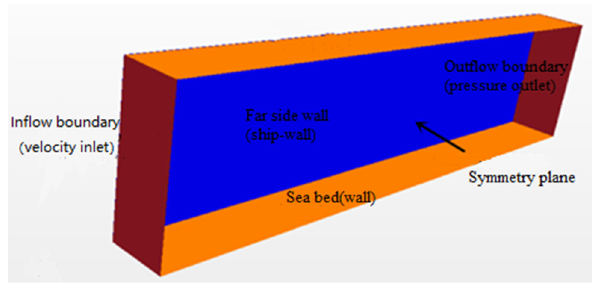
Figure 3. Computational domain and domain boundaries.